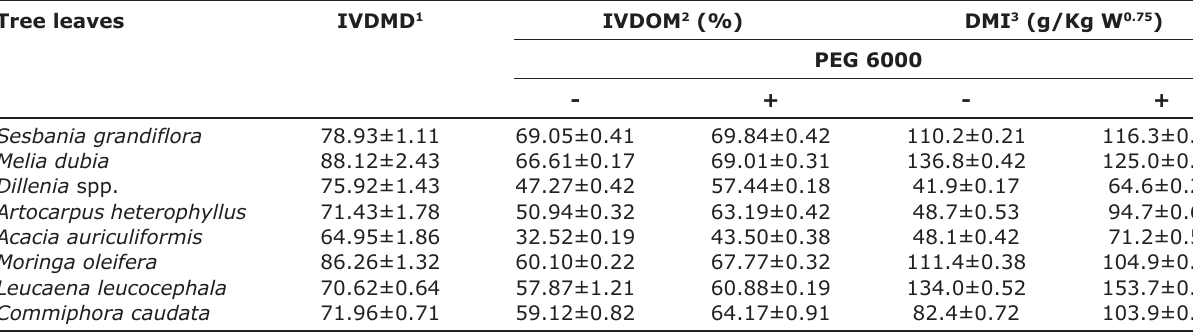
All values were mean of triplicates. + Indicates with PEG and -indicates without PEG. 1 IVDMD (%) - As per modified two-stage fermentation using Ankom 200 Fiber Bag Analyzer. 2 IVDOM (%)=14.88+0.8893 GP+0.0448 CP+0.0651